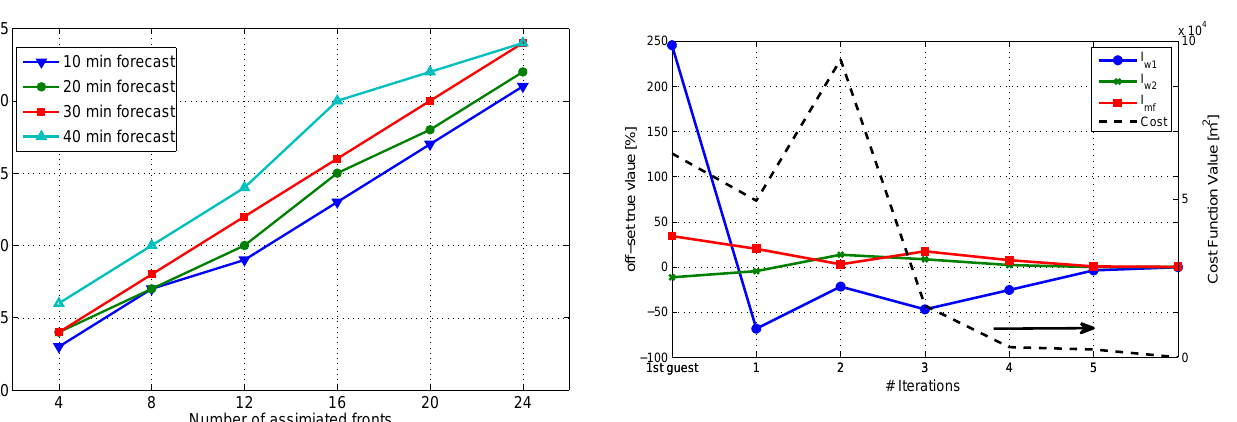
Figure 7. Convergence of the cost function and the invariants when wind speed and direction are used as an input. The peak in the third iteration of the cost function is due to the correcting algorithm that resets negative